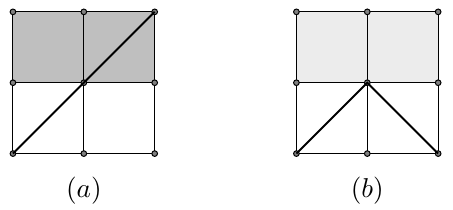
Figure 2 . The two cases where we assign the weight c i = x i to the middle point located at position i . Scanning from left to right, (a) the path enters the ground-state (shaded) band from a non-ground-state (white) band below at the middle point, (b) the path reaches a peak at the middle point outside the ground-state (shaded) band. A lightly-shaded band (the upper band in (cid:12)gure (b)) can be a ground-state band or not.